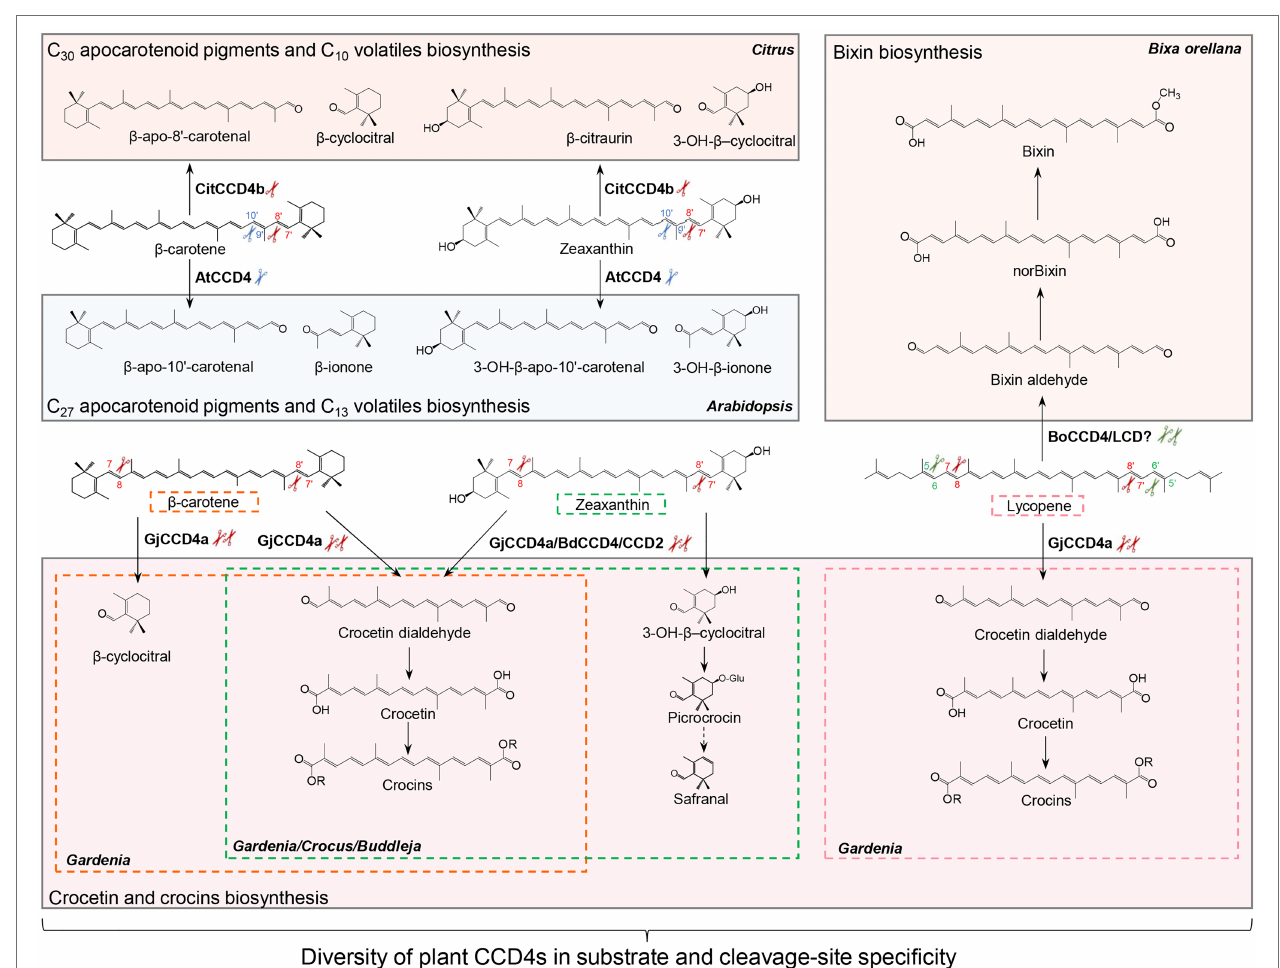
FIGURE 3 | Diversity of carotenoid cleavage dioxygenase 4 (CCD4) cleavage reactions. Names of apocarotenoids are shown in black. Names of carotenoid cleavage dioxygenases are in depicted black boldface. Scissors in different color indicate the positions cleaved by CCD4 or CCD2 enzymes from different plant species. Abbreviations: CitCCD4b, Citrus CCD4b; AtCCD4, Arabidopsis thaliana CCD4; GjCCD4a, Gardenia jasminoides CCD4a; BdCCD4, Buddleja davidii CCD4, CsCCD2, Crocus sativus CCD2; and BoCCD4/LCD, Bixa orellana